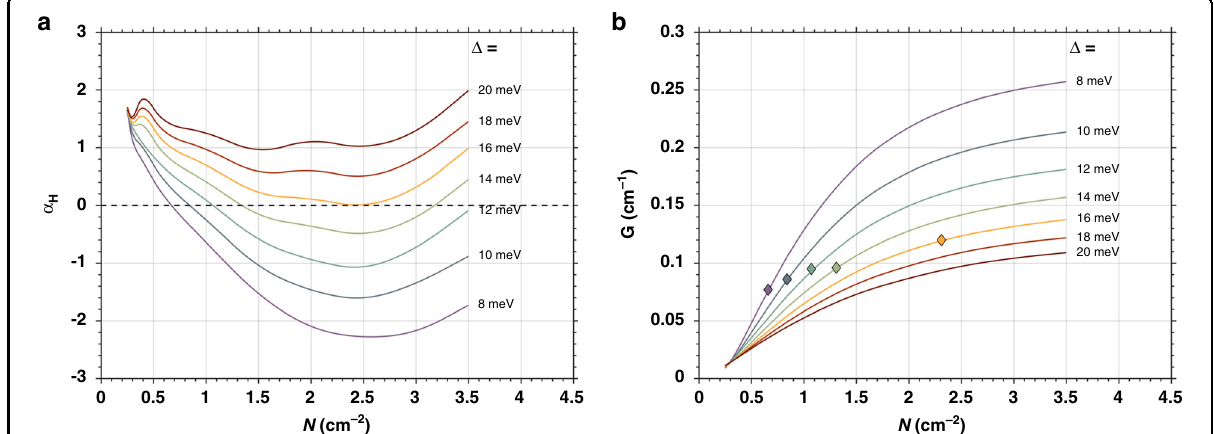
Fig. 6 Simulated material properties of epitaxial QD lasers on silicon. ( a ) Gain peak linewidth enhancement factor ( α H ) and ( b ) peak gain as a function of carrier density (N) for ground-state transition with different inhomogeneous widths are indicated. The p-dope density is 10 12 cm − 2 and the diamonds show the peak gain when α H =